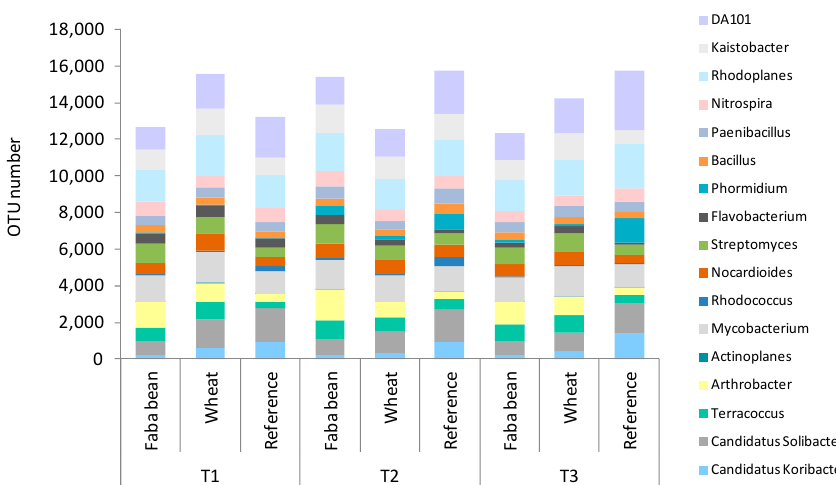
Figure 5. Number of OTUs of the dominant bacterial genera as affected by forecrop, OTUs less than 2% were not analyzed. T1, T2, and T3 denote: two months after residue incorporation into the soil, stem elongation, and the senescence stage of the subsequent wheat crop, respectively.